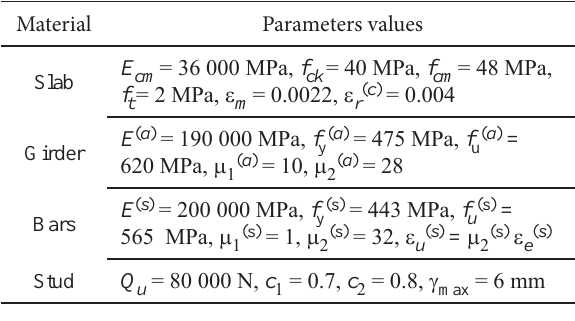
Table 1. Mechanical characteristics